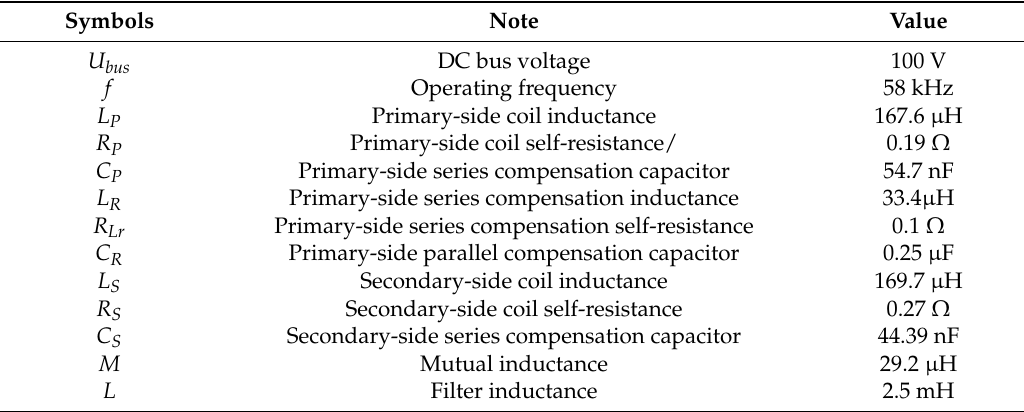
Table 2. Experiment platform parameters.